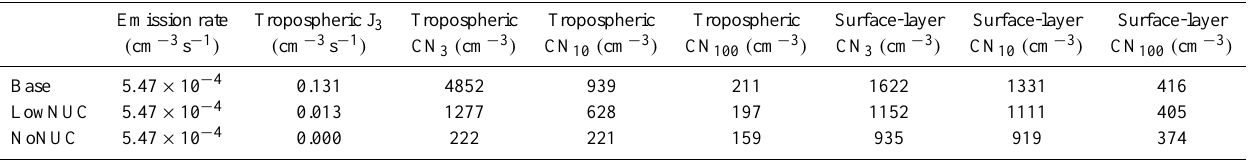
Table 8. Summary of the global annual average of tropospheric and surface-layer aerosol number budgets including J 3 (new particle forma- tion rates at 3nm), CN 3 (number concentration of particles with Dp ≥ 3nm), CN 10 (Dp ≥ 10nm), and CN 100 (Dp ≥ 100nm) in ModelE2- TOMAS. Values normalized by tropospheric volume at 273K and